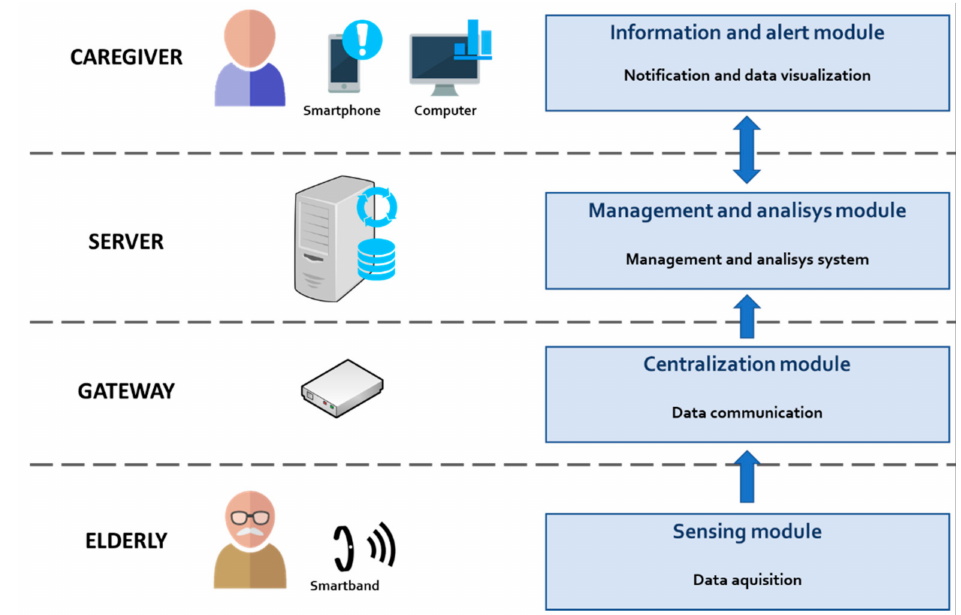
Figure 1. Testbed architecture.